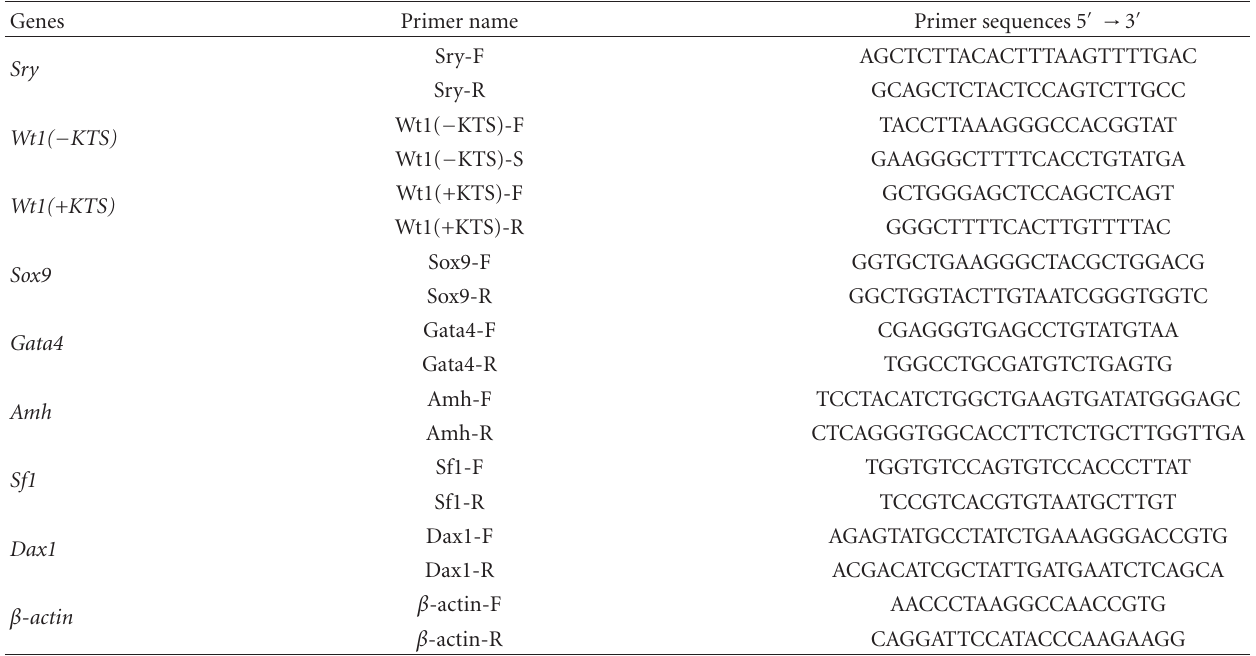
Table 2: Primers used for real-time RT-PCR